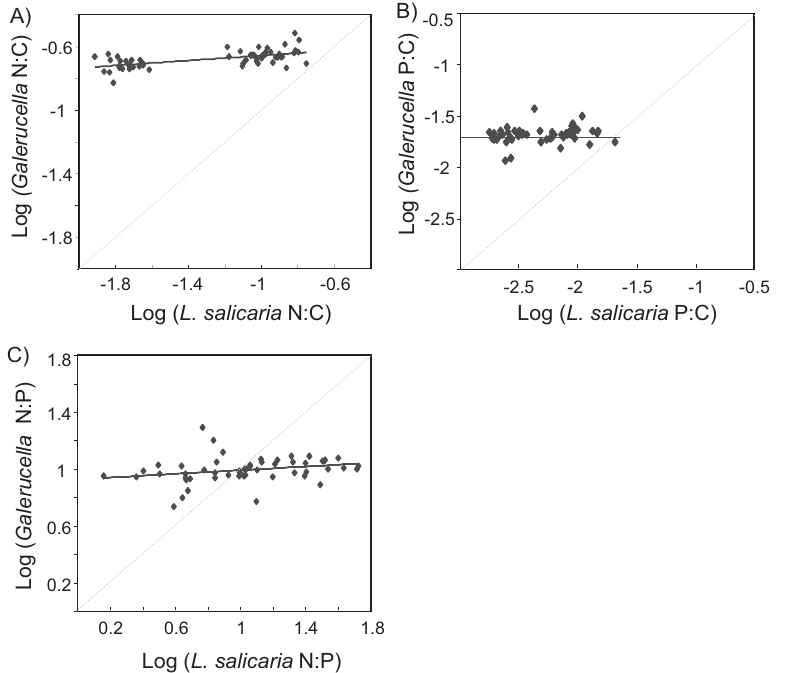
Figure 5. Relationships between elemental ratios of Lythrum salicaria and Galerucella . The thin line indicates a one-to-one relationship, where plant and beetle elemental ratios are